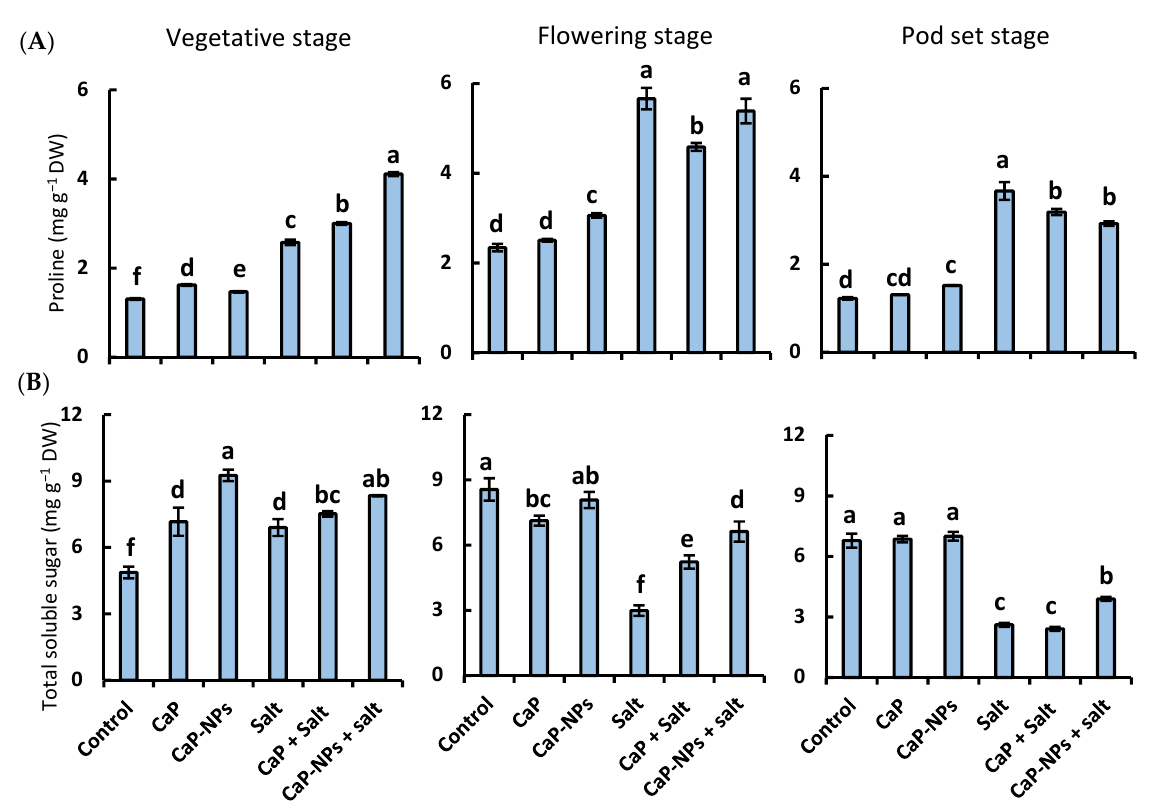
Figure 7. Effect of different treatments on ( A ) the proline content and ( B ) total soluble sugars of broad bean plants in 3 growth stages. The same letters indicate no significant difference ( p < 0.05) as analyzed by the Duncan test. Each value is the average of 3 replicates ± SE.